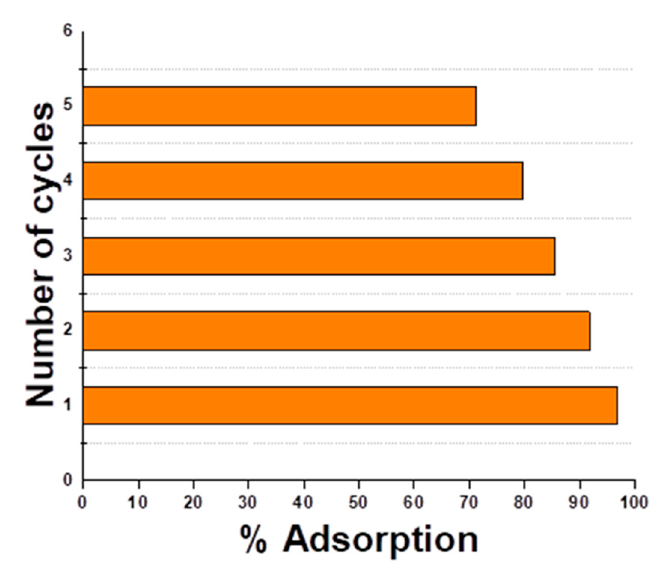
Figure 12. Reusability assays of m-CGPA.